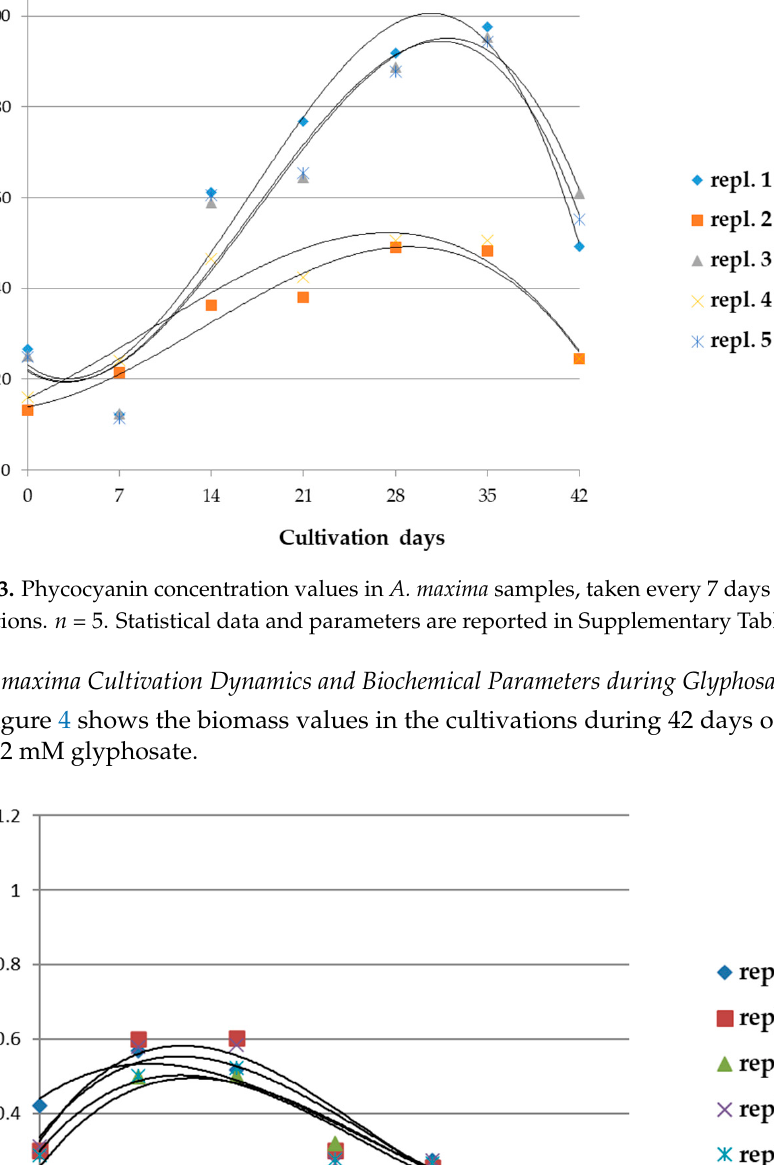
Figure 4. Biomass values evaluated as absorbance of reference samples treated with 0.2 mM glyphosate from cultivations of A. maxima . n = 5. Details of the data are shown in Supplementary Table S1F.